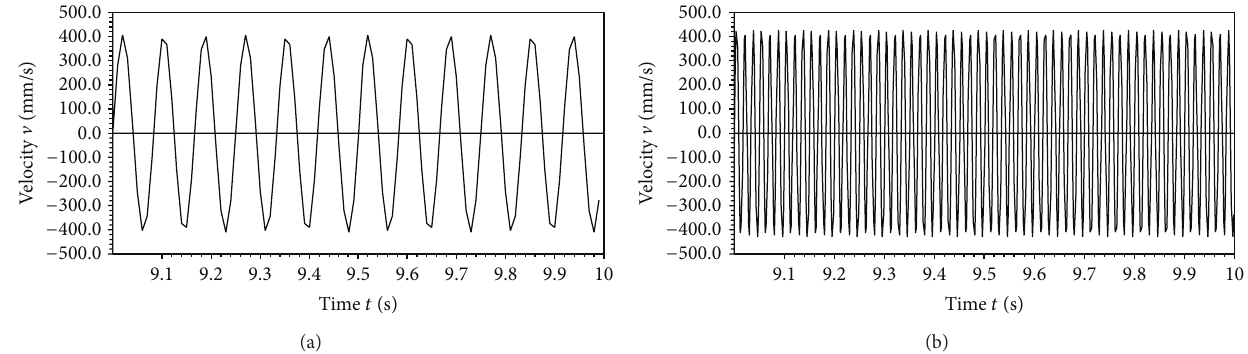
Figure 7: The velocity similarity of the vibrating screen. (a) The velocity of the prototype screen. (b) The velocity of the model screen.